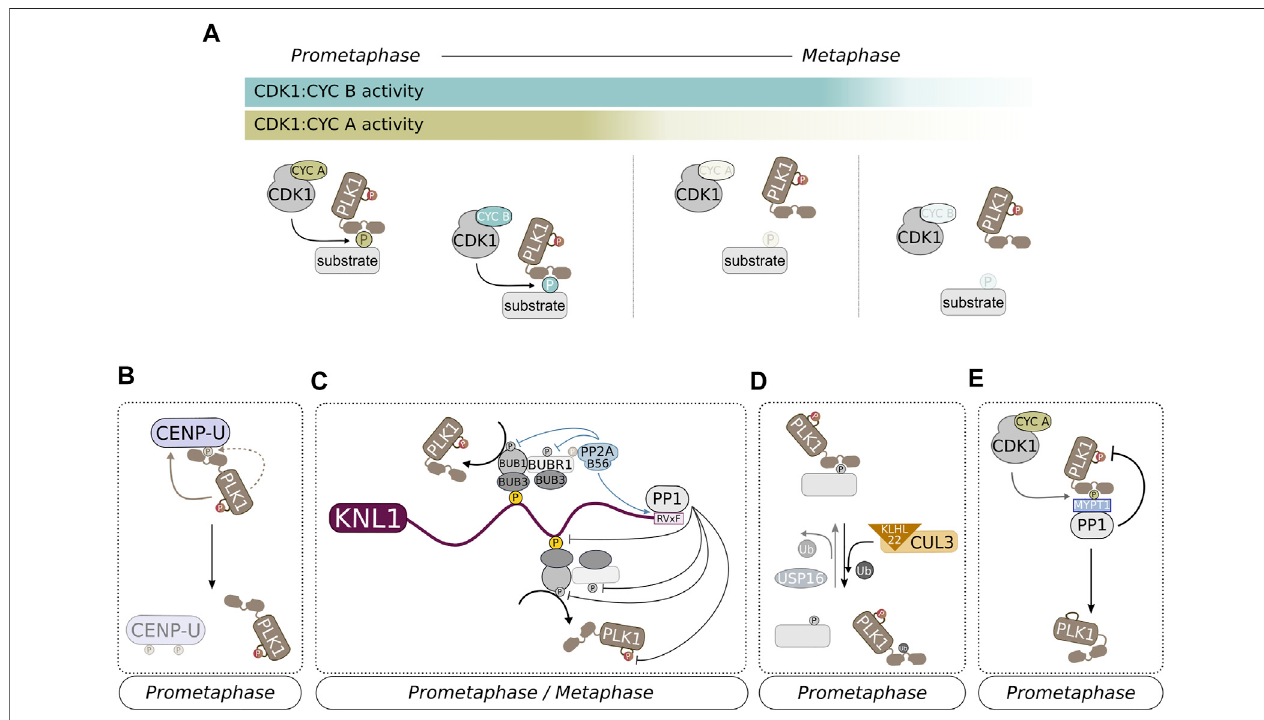
FIGURE 5 | Silencing of PLK1 activity coincides with chromosomes alignment during metaphase. (A) The degradation of CYCLIN A and CYCLIN B at the prometaphase-to-metaphase and metaphase-to-anaphase transitions, respectively, precludes the continuous priming of PLK1 substrates and contributes to silence the activity of the kinase at KTs. (B), (C), (D) and (E) Examples of other regulatory mechanisms to control PLK1 activity and function during prometaphase and metaphase. (B) PLK1 promotes its own release from KTs by targeting CENP-U/PBIP1 for degradation. (C) PP1 bound to KNL1 has been suggested to regulate PLK1 localization during metaphase by dephosphorylating key components required for PLK1 recruitment. A similar regulatory function has been proposed for PP2A: B56, which is recruited to KTs during prometaphase. (D) PLK1 localization is also regulated by non-proteolytic deubiquitination/ubiquitination of the PBD. (E) Other regulatory mechanisms control PLK1 activation status. For instance, CDK1:CYC A primes MYPT1, a PP1 regulatory subunit, and directs it to PLK1, thereby promoting PP1-mediated dephosphorylation of PLK1 ’ s T-loop.